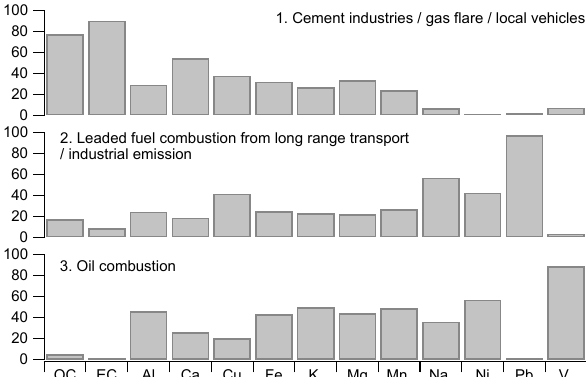
Figure 10. Source profile of PMF analysis of combined PM 2 . 5 OC and EC and PM 10 metal concentrations. The sum of the species for all the factors was normalized to